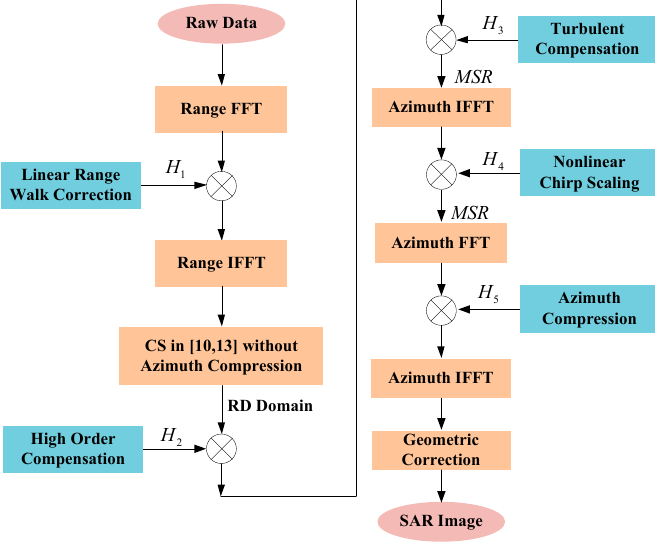
Figure 3. Block diagram of proposed generalized nonlinear chirp scaling (GNLCSA).